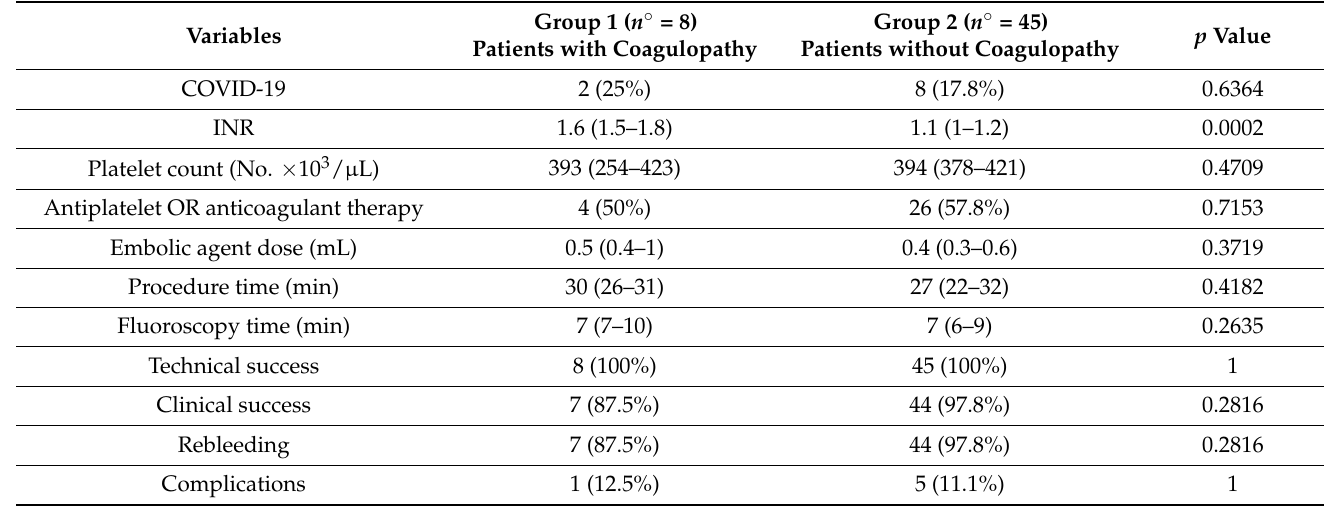
Table 4. Comparison of data between patients with and without